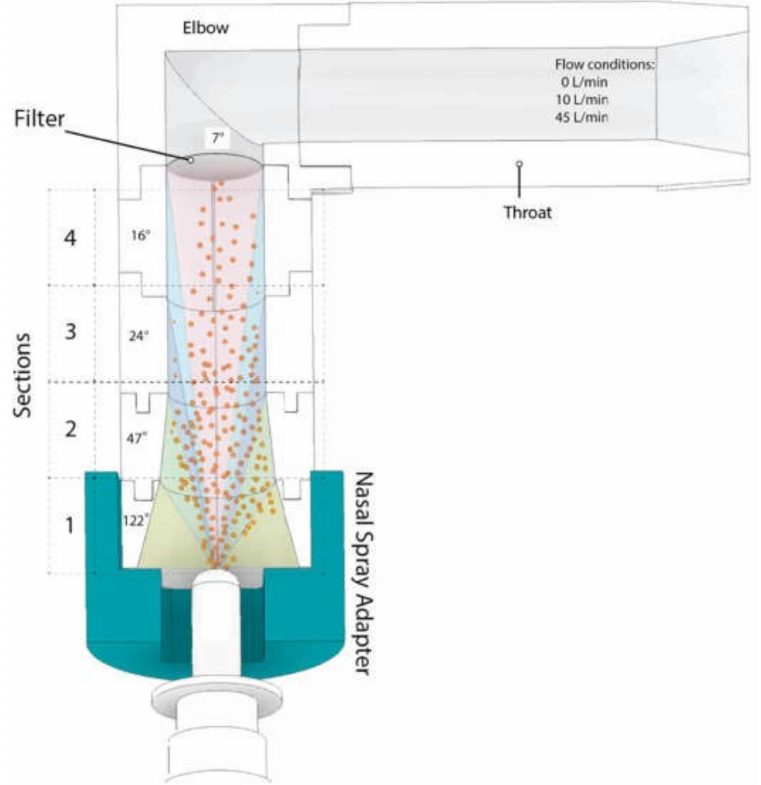
Figure 4. Experimental layout for use of the Plume Induction Port Evaluator (PIPE) with nasal sprays. The illustration represents in colors the effective angles used to calculate mass median plume angles (MMPA). Reproduced with permission from [75], Elsevier,